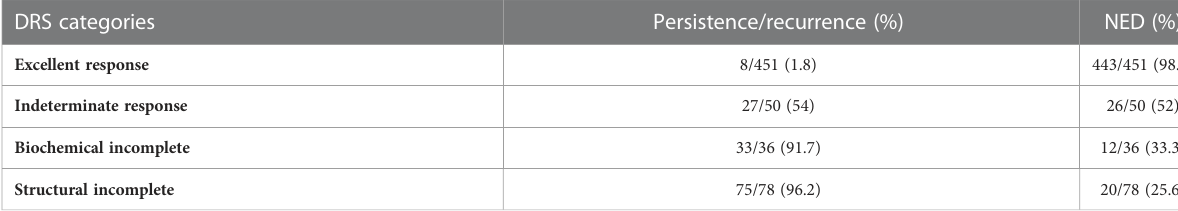
TABLE 4 Outcomes concerning no evidence of disease (NED) in the different DRS categories.